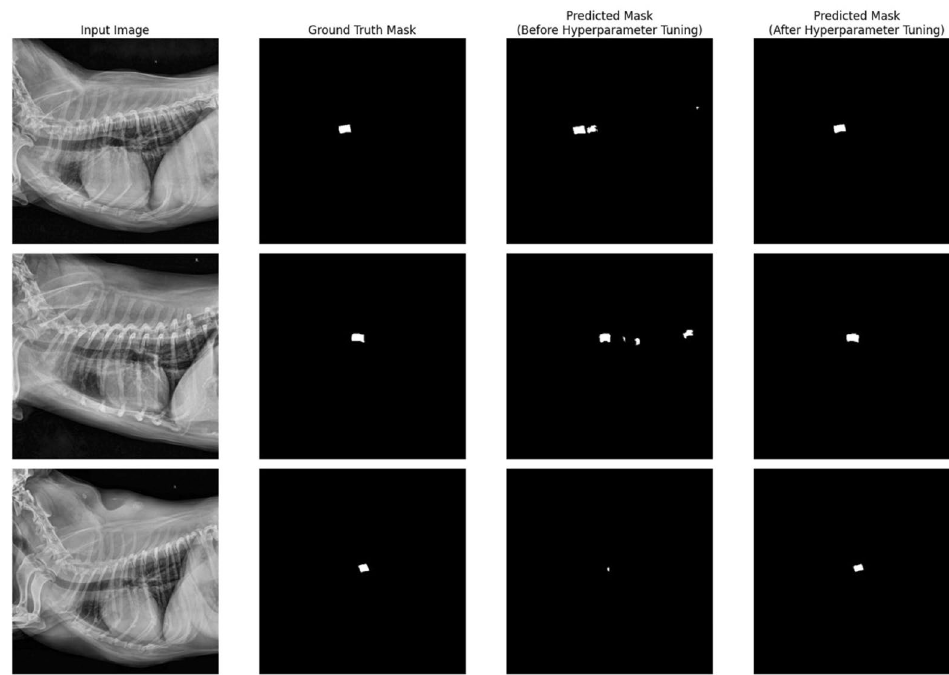
Figure 5. Input images, ground truth masks, and predicted masks for T4 body segmentation model with default and optimized hyperparameter setting.